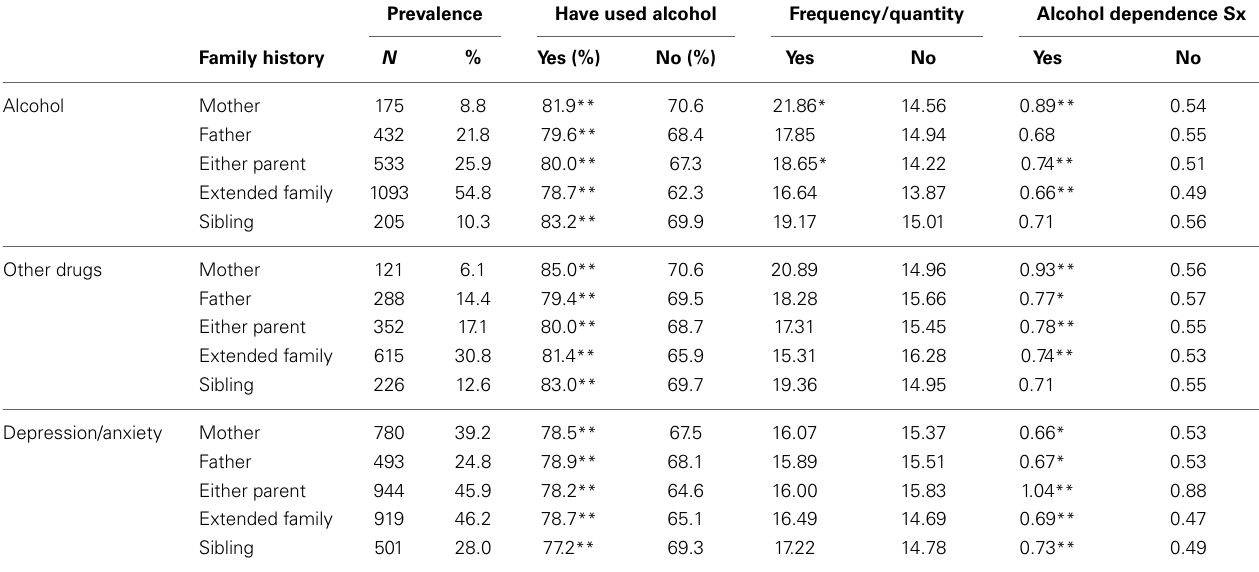
Table 4 | Endorsement rates for perceived family history of substance use and other mental health problems, and association with alcohol use